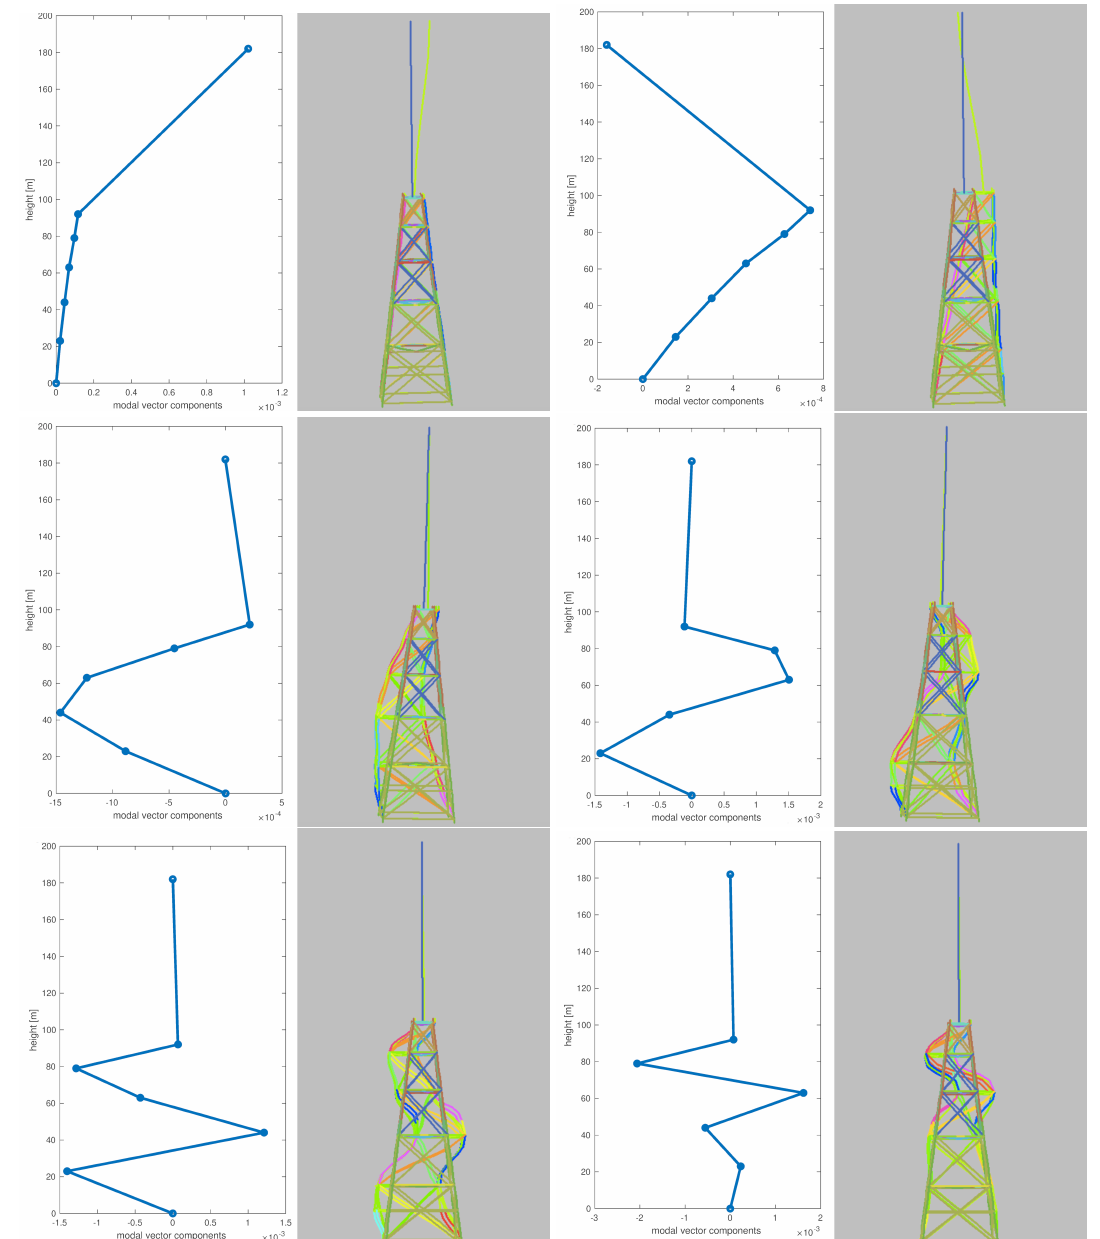
Figure 9. Vibrational mode comparison between the 6DOF and FE